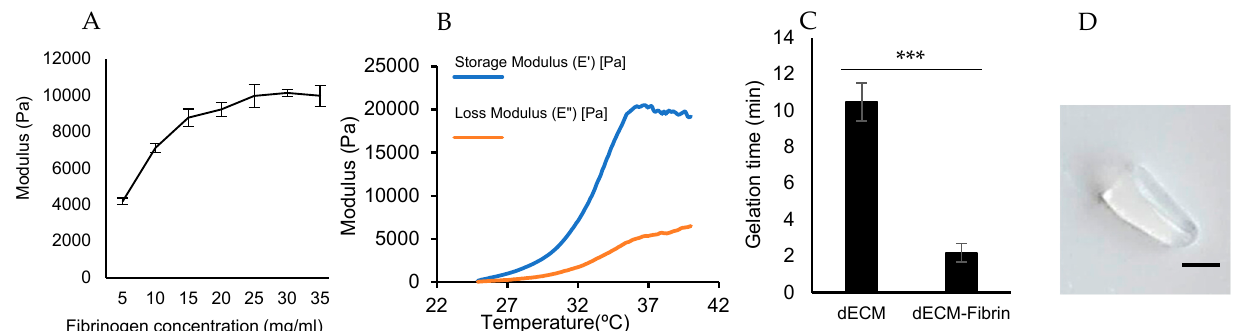
Figure 3. Mechanical characterization. ( A ) The stiffness of fibrin gels at different concentrations at room temperature is shown. This stiffness allows an accurate determination of the optimum concentration of fibrinogen in the hydrogel. ( B ) Storage and loss moduli of the dECM-fibrin hydrogel in a temperature scan (from 25 to 40 ◦ C) is presented. The calculation of hydrogel’s Young’s modulus revealed comparable values to the native heart. ( C ) Depiction of the gelation time of the dECM and dECM-fibrin hydrogels, at 37 ◦ C. Our experiments demonstrate that 2 min gelation are sufficient for secure handling/manipulation of dECM-fibrin hydrogels. *** = significant difference, p < 0.001 (N = 3–4 per condition). ( D ) Macroscopic appearance of the gelated hydrogels (Scale bar: 5